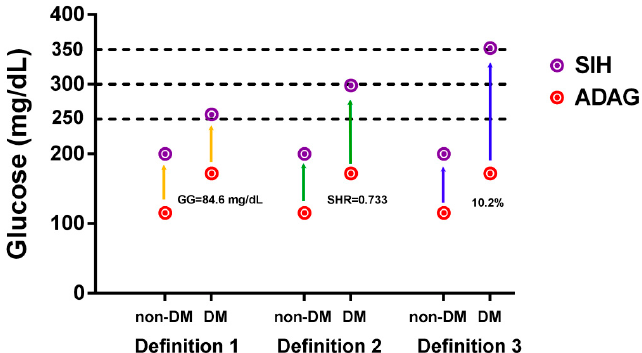
Figure 2. The defined glucose level by three different definitions of SIH in diabetes, based on the assumption that stress causes the same (1) elevation of glucose (glycemic gap); (2) glucose elevation percentage (i.e., SHR); and (3) percentage of patients with SIH, both in patients with and without diabetes.